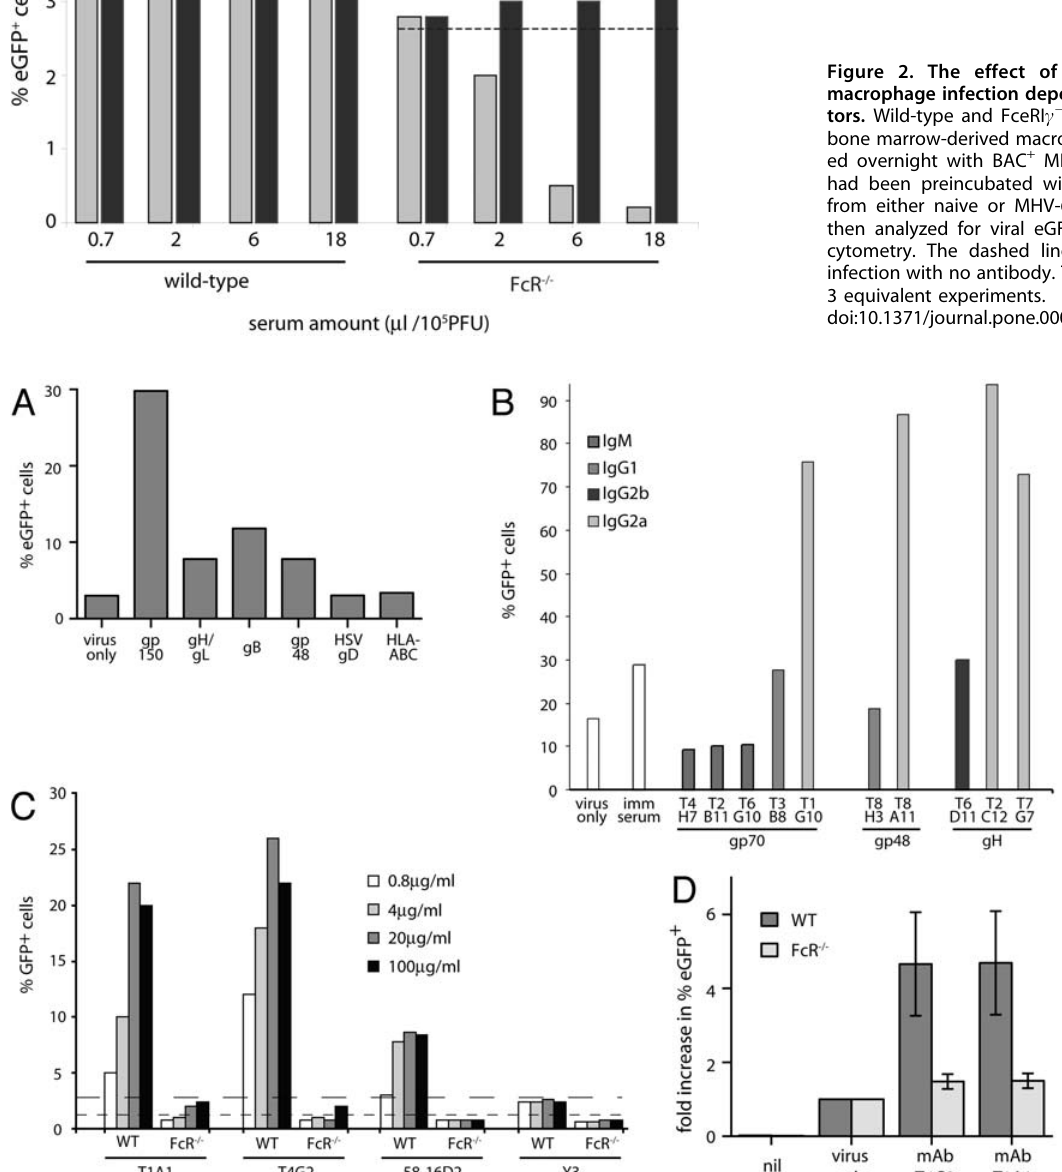
Figure 3. MHV-68 glycoprotein-specific monoclonal antibodies enhance the infection of Fc receptor + cells. A. Purified BAC + virions (10 6 PFU/ml) were incubated (1 h, 37 u C) either alone (virus only) or with isotyped-matched mAbs (all IgG2a at 10 m g/ml): gp150-T1A1, gH/gL-T2C12, gB-T7H9, gp48-6D10. MAbs LP2 (anti-HSV gD) and W6/32 (Anti-HLA-ABC) provided negative controls. The virion/antibody mixtures were added to RAW264.7 cells (3PFU/cell). Infection was quantitated 18h later by flow cytometry of viral eGFP expression. The data shown are representative of . 10 different experiments with at least 4 different mAbs tested for each viral protein. T2C12 is a neutralizing mAb, but 10 m g/ml corresponds to a sub-neutralizing dose for the amount of virus used. B. BAC + MHV-68 virions were incubated (1 h, 37 u C) with no serum (virus only), 1% MHV-68-immune serum (imm serum), or mAbs of different isotypes as indicated (10 m g/ml) and then added to RAW264.7 cells (5PFU/cell). Viral eGFP expression was quantitated by flow cytometry 18h later. The data are from 1 of 5 equivalent experiments. C. Wild-type (WT) and FceRI c 2 / 2 Fc c RIIB 2 / 2 (FcR 2 / 2 ) bone marrow-derived macrophages were incubated overnight with BAC + MHV-68 virions plus mAb dilutions as shown. T1A1 and T4G2 recognize gp150, 58-16D2 recognizes gp60 and Y3 is an H2-K b -specific control. The dashed lines show infection with no antibody for WT (coarse dashes) and FcR 2 / 2 macrophages (fine dashes). The data are from 1 of 3 equivalent experiments. D. Wild-type (WT) or CD16 2 / 2 CD32 2 / 2 CD64 2 / 2 (FcR 2 / 2 ) bone marrow- derived macrophages were left uninfected (nil) or infected (3PFU/cell) with BAC + virions that had been preincubated or not (virus only) with gp150- specific mAbs as shown (T4G2, T1A1). Infection was quantitated 18 h later by flow cytometric assay of viral eGFP expression. Virus alone typically gave eGFP expression in 1–2% of bone marrow macrophages. The bars show mean 6 SD results from 3 experiments. doi:10.1371/journal.pone.0000560.g003 PLoS ONE | www.plosone.org